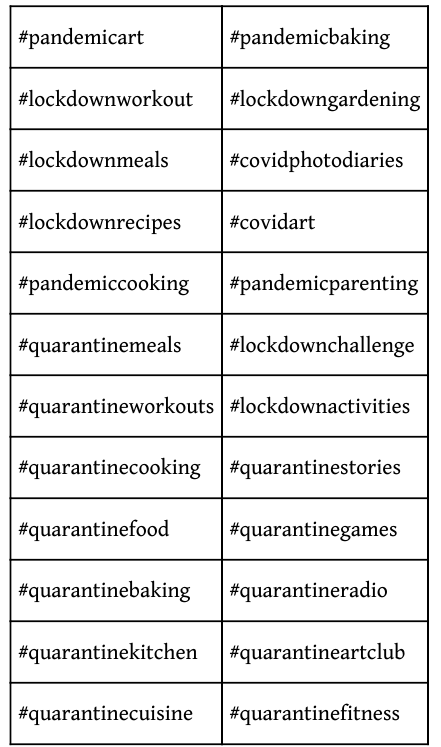
Table 9: Examples of hashtags that journals life during COVID